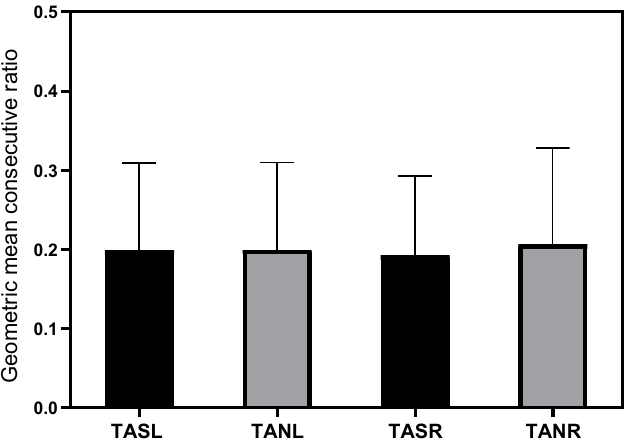
Figure 5. Effects of recording electrode type on geometric mean consecutive ratio of mTc-MEP amplitudes. The x-axis denotes the different muscles and recording electrodes used for mTc-MEP monitoring, and the y-axis denotes the geometric mean consecutive ratio. The mean MCR and SD (whiskers) of the mTc-MEP amplitudes for the surface electrodes (black bars) and subcutaneous needle electrodes (gray bars) are shown. Geometric mean consecutive ratios were not significantly different between electrode type and side. TASL, tibialis anterior surface left; TANL, tibialis anterior subcutaneous needle left; TASR, tibialis anterior surface right; TANR, tibialis anterior subcutaneous needle right.